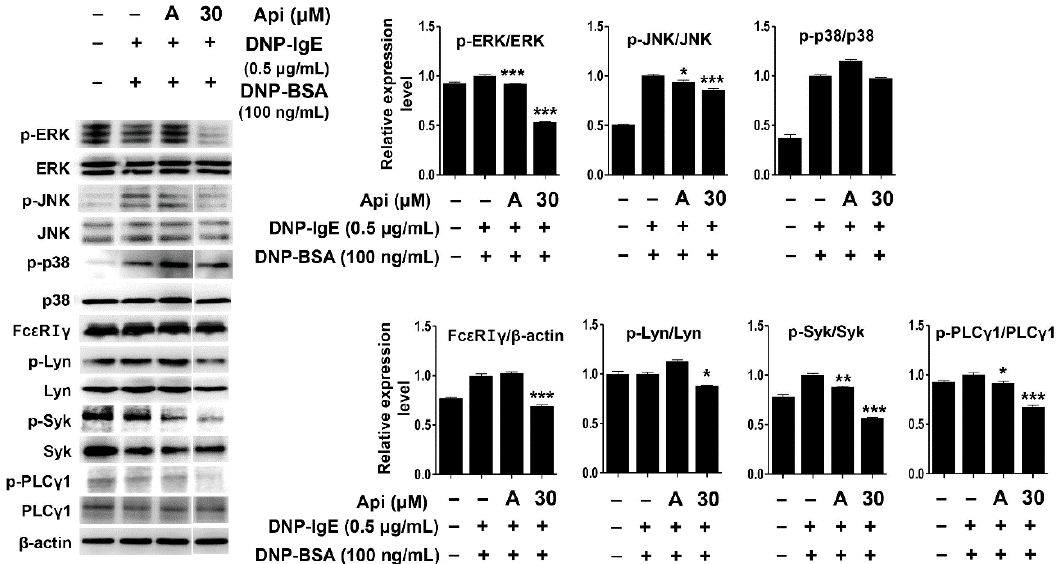
Figure 5. Effects of apigenin on mitogen-activated protein kinase (MAPK) and IgE-activated signaling molecules in RBL-2H3 cells. Cells were treated with apigenin (30 μ M), 0.5 μ g/mL DNP-IgE, and 100 ng/mL DNP-BSA. Api, apigenin; A, cyclosporine A (1 μ g/mL). The data were analyzed using one- way analysis of variance (ANOVA) followed by Tukey’s test. * p <0.05, ** p <0.01, *** p <0.001 versus DNP-IgE- and DNP-BSA-treated cells without apigenin exposure.